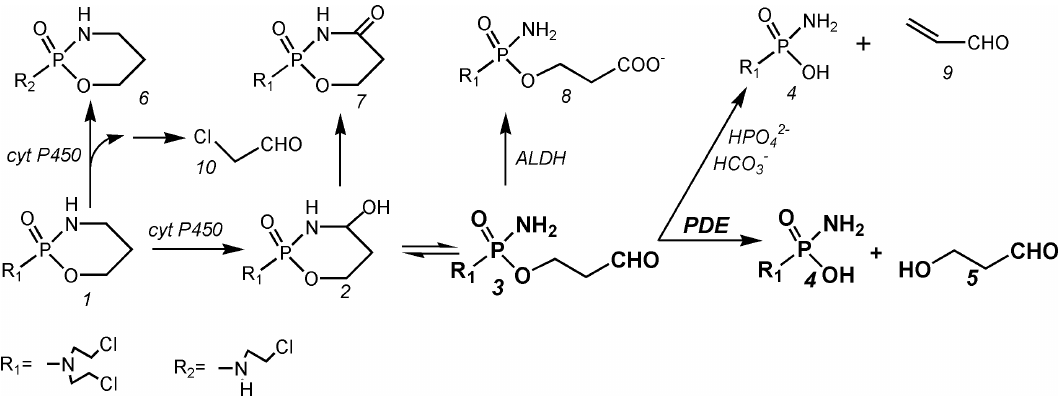
Figure 1. Main metabolic pathways of cyclophosphamide (for details, see text). 1 cyclophosphamide (CP), 2 4-hydroxycyclophosphamide (OHCP), 3 aldophosphamide (ALDO), 4 phosphoreamidemustard (PAM), 5 hydroxypropanal (HPA), 6 dechlorocyclophosphamide, 7 4-ketocyclophosphamide (KCP), 8 carboxyphosphamide (CARB), 9 acrolein, 10